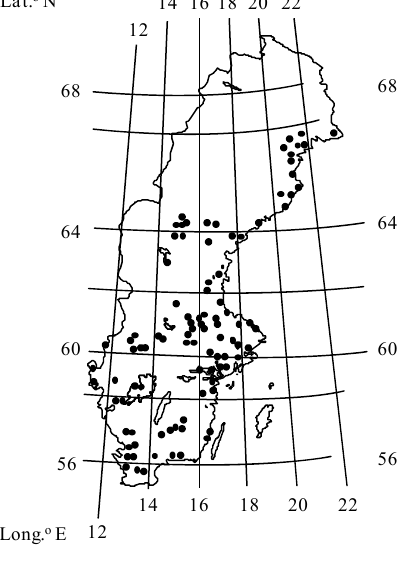
Figure 1. Locations of the sampled Norway spruce trees growing on former farmland. Lat. o